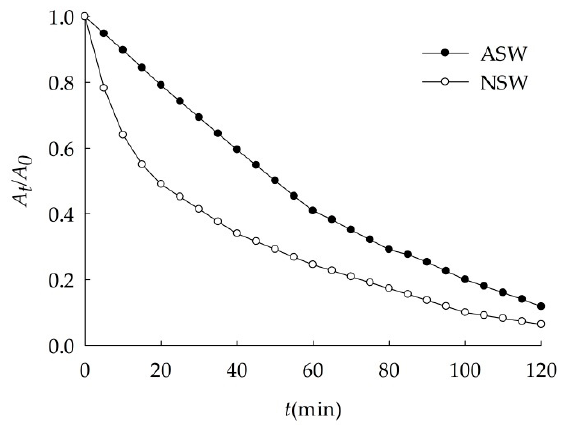
Figure 7. Sedimentation of nano-Al 2 O 3 in NSW and ASW ( S = 29.8, pH = 7.95). Table 9. Dynamics fitting of nano-Al 2 O 3 sedimentation in NSW and ASW. Medium